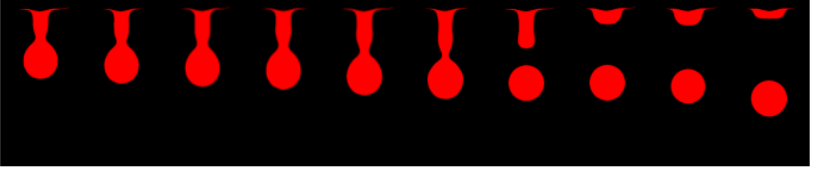
Figure 15. The shape of the droplets outside the nozzle at different times.